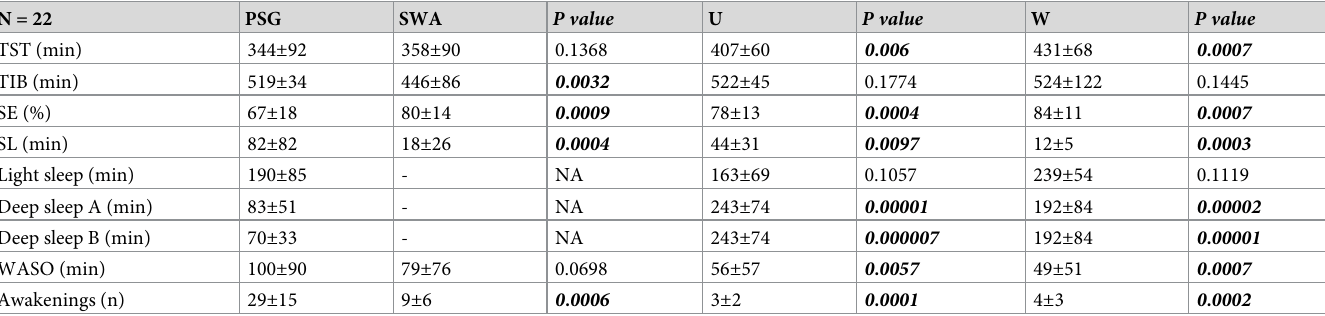
Table 1. Single comparisons of sleep parameters obtained by polysomnography (PSG) vs sleep